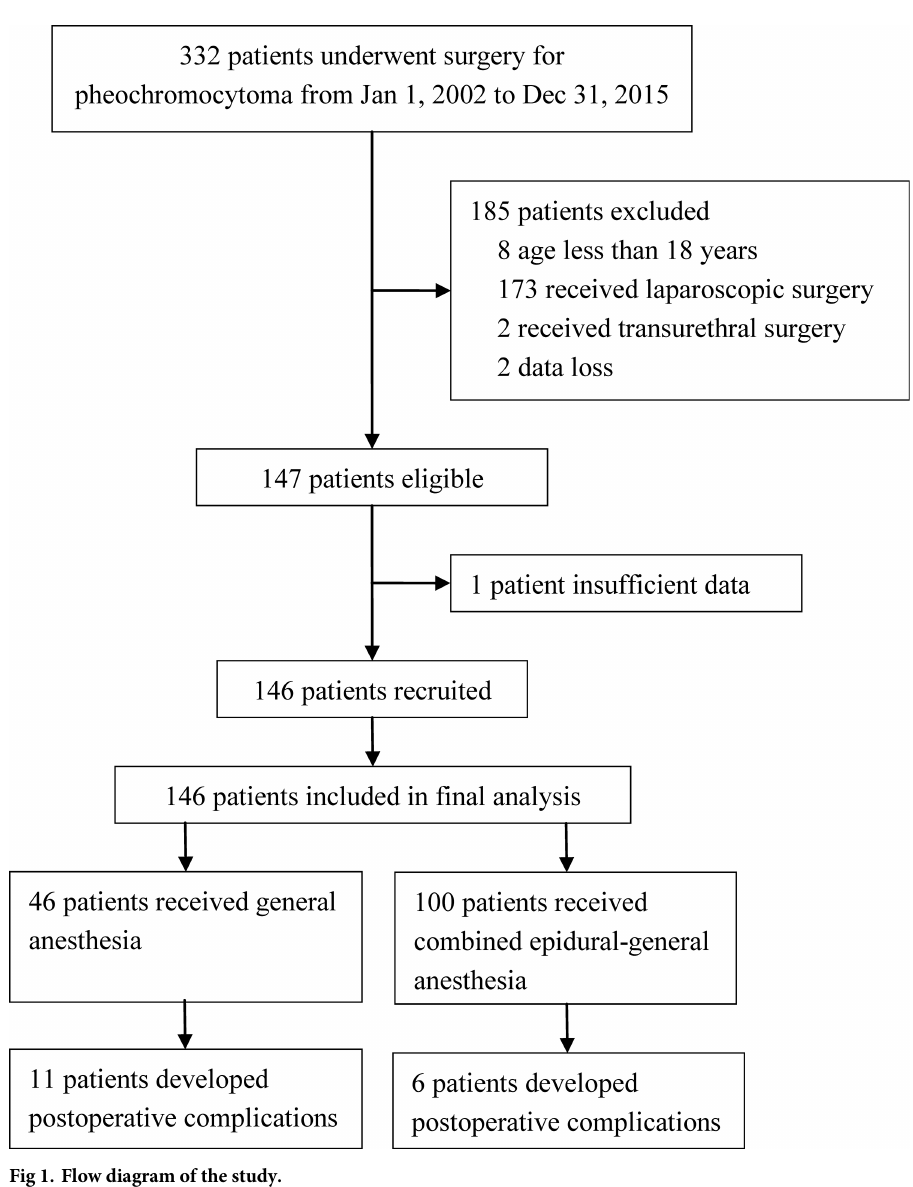
Fig 1. Flow diagram of the